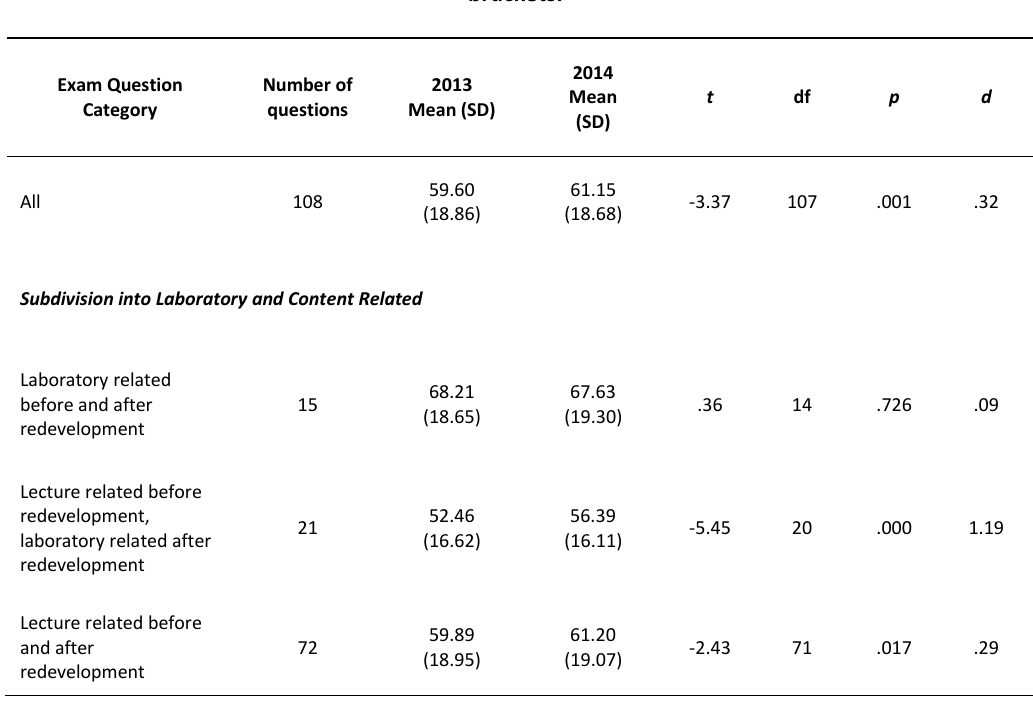
Table 1: Summary of statistical analysis on exam question data. Standard deviation (SD) is shown in